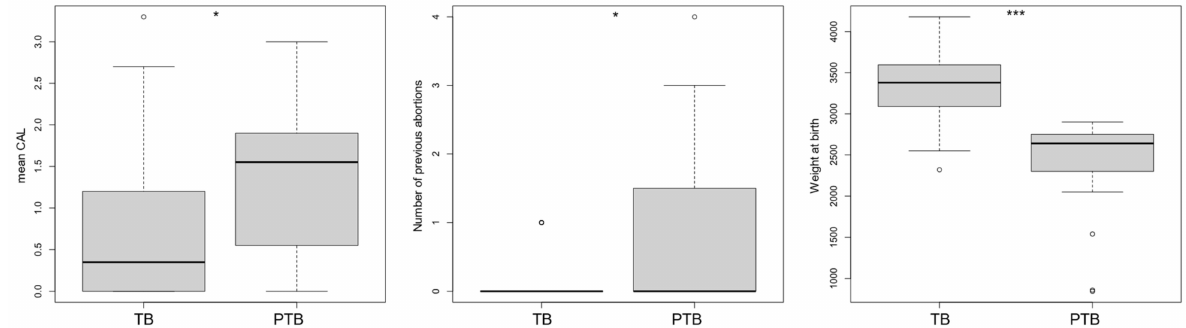
Figure 2. Impact of the clinical parameters and alpha diversity index on the risk factor, generalized linear model: mean CAL; number of previous abortions; weight of child. Note: TB = Term birth; PTB = Preterm birth; CAL = clinical attachment loss; * p < 0.05; *** p < 0.001; ◦ = outliers.